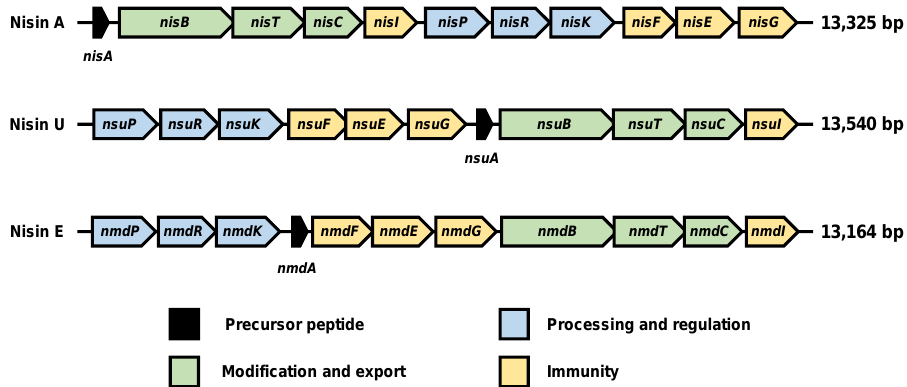
Figure 1. Comparison of the nisin A ( L. lactis ) [21], nisin U ( S. uberis ) [10] and nisin E ( S. equinus ) biosynthetic